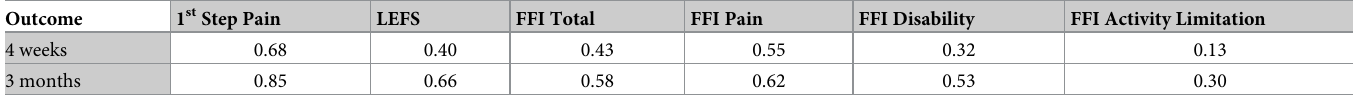
Table 3. Between-group effect sizes (SMD) in favor of the dry needling group when compared to conventional physical therapy (manual therapy, exercise and ultrasound).